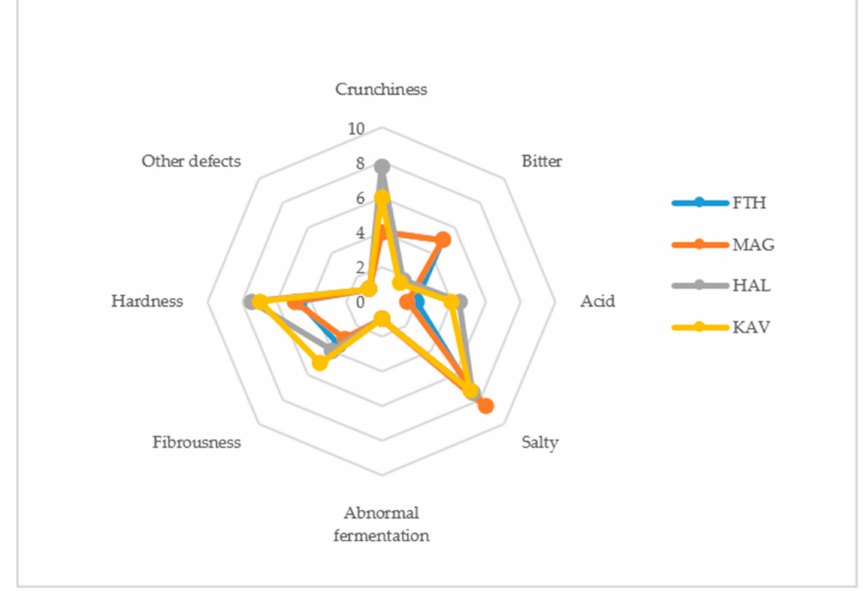
Figure 2. Spider graph showing the sensory profiles (original scores) for the diverse fermented table olives samples. FTH (origin, Fthiotida; cultivar, Konservolia), MAG (Magnesia; Konservolia), HAL (Halkidiki; Halkidiki), KAV (Kavala;